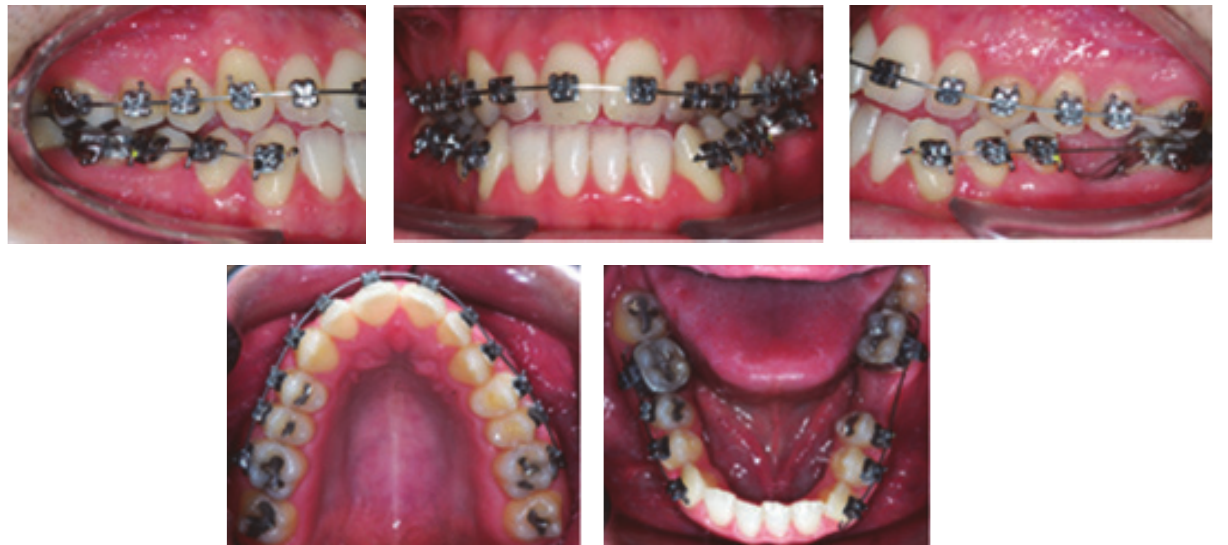
Figure 3: Intraoral views of treatment. Start of leveling, extraction of tooth 36, and segmented arch in the lower